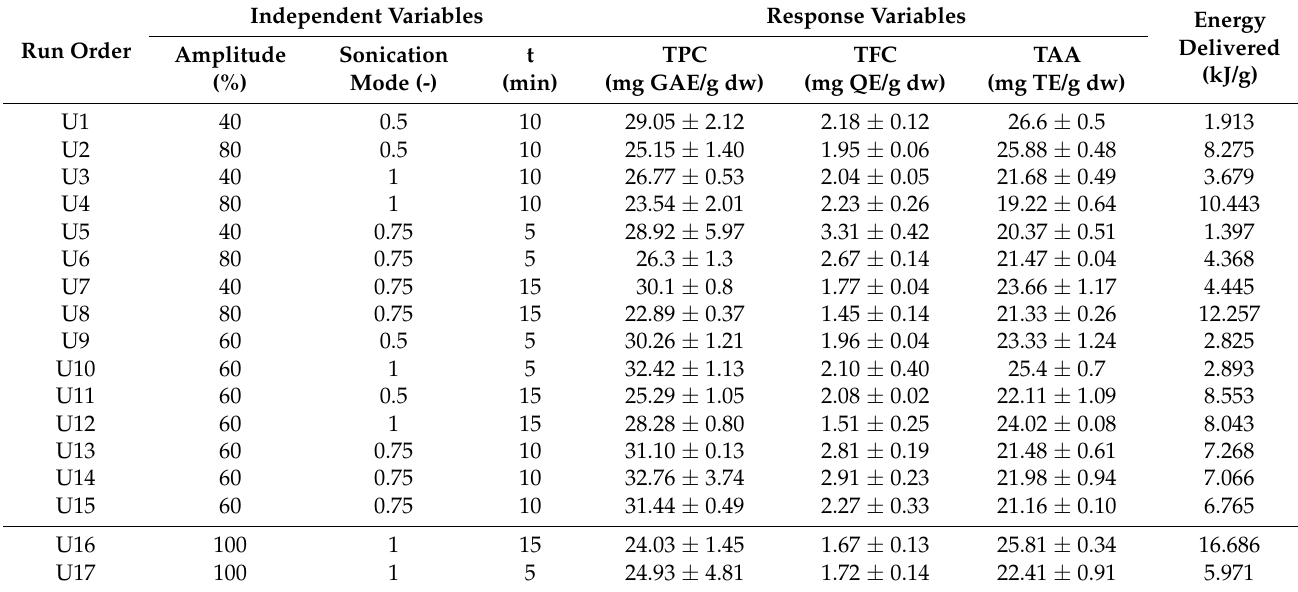
Table 3. Box-Behnken experimental design (BBD) with independent variables and experimental values for the responses of total polyphenols, total flavonoids, and total antioxidant activity from cornelian cherry extracts obtained by UAE.